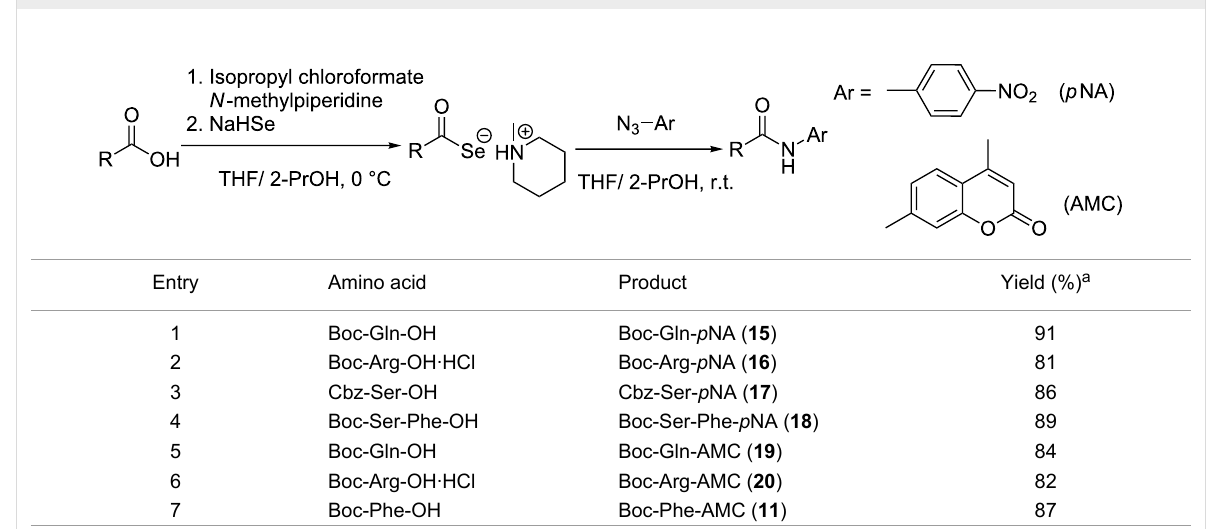
Table 2: The 3-step one-pot selenocarboxylate/azide amidation to synthesize N α -protected aminoacyl- p NAs and aminoacyl-AMCs (Procedure B).